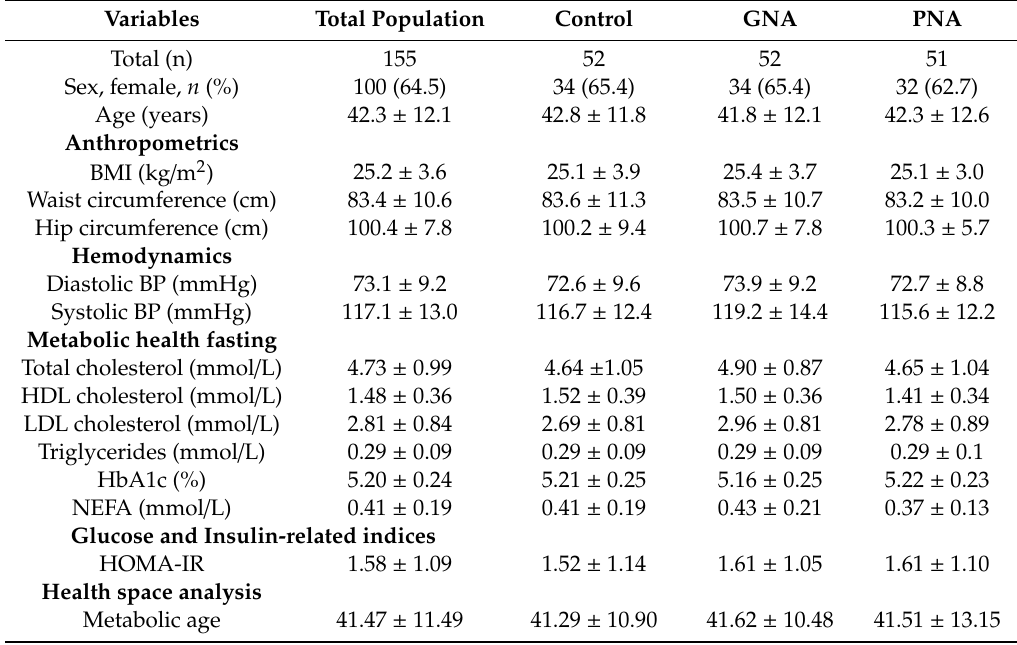
Table 1. Baseline characteristics of the study